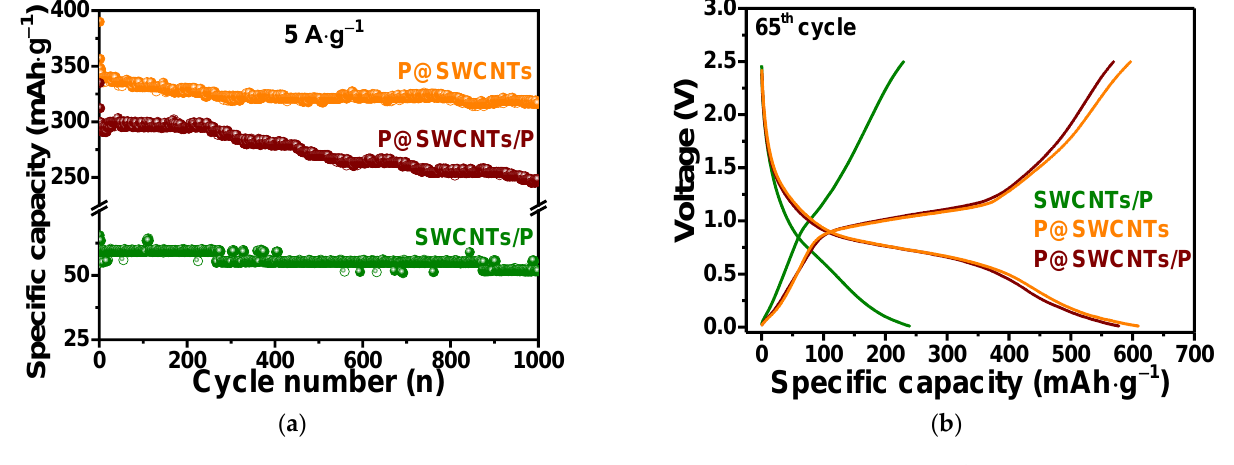
Figure 7. ( a ) Long-term cycling of composite nanomaterials at 5 A · g – 1 and ( b ) GDC curves measured at 65th cycle at a current density of 0.1 A·g – 1 .